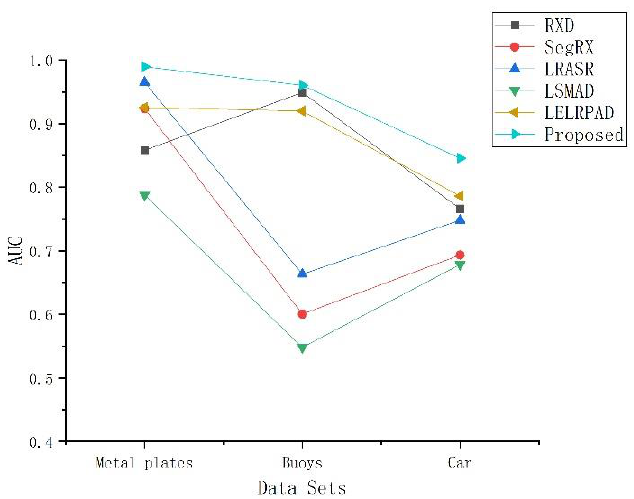
Figure 16. Line charts of the area under the receiver operating characteristic curve (AUC) scores.